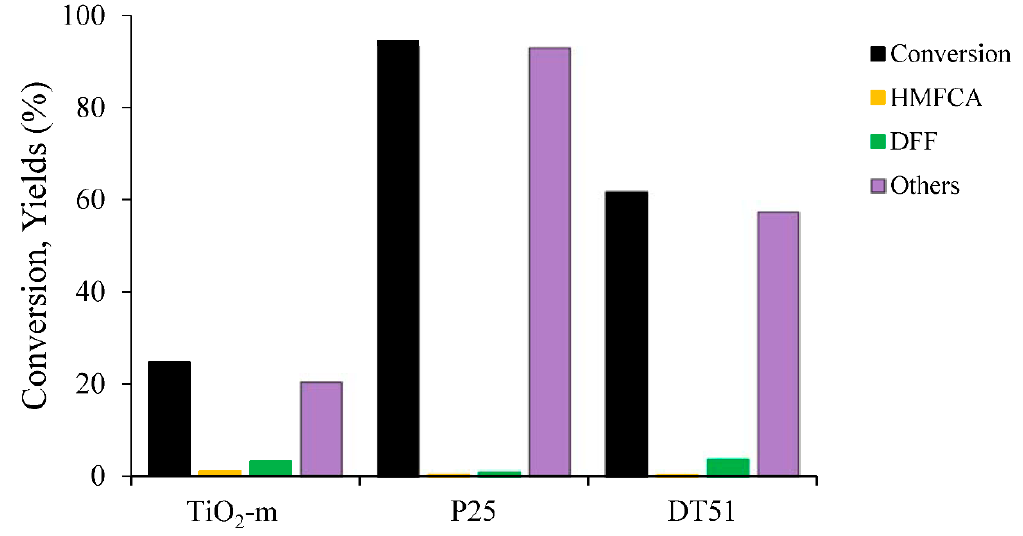
Figure 6. Photocatalytic activity of different titania powders. Reaction conditions: t = 1 h, T = 30 °C, P = 1 atm O 2 , m cat = 20 mg, V = 20mL, [HMF] 0 = 5 × 10 − 4 mol/L.